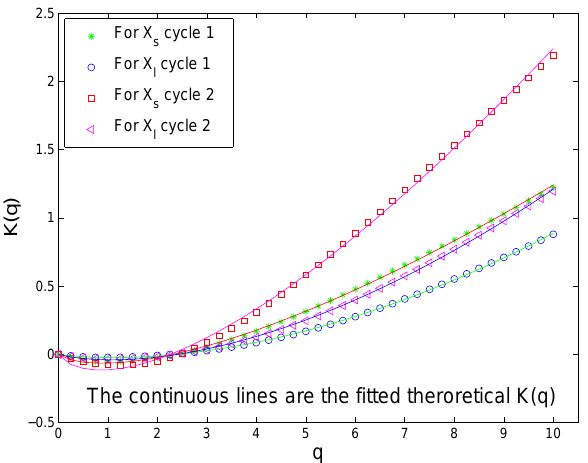
Fig. 3. The K(q) curves of the raw daily X l and X s data (the dotted curves), and their fitted curves (continuous lines) by the universal multifractal model. Table 1. The estimated values of H , C 1 and α in the universal mul- tifractal model and h( 2 ) in the MF-DFA for the daily solar X-ray data. Here error means the minimal value in Eq. (4).